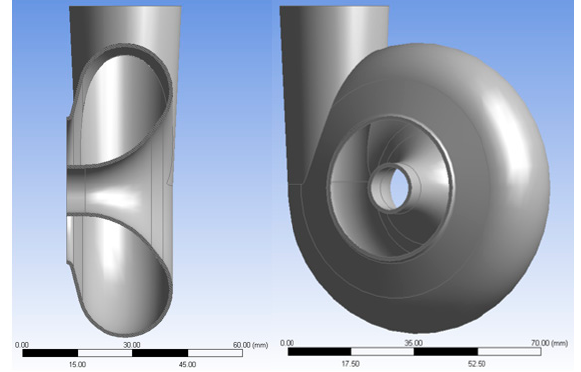
Figure 7. Second volute design.